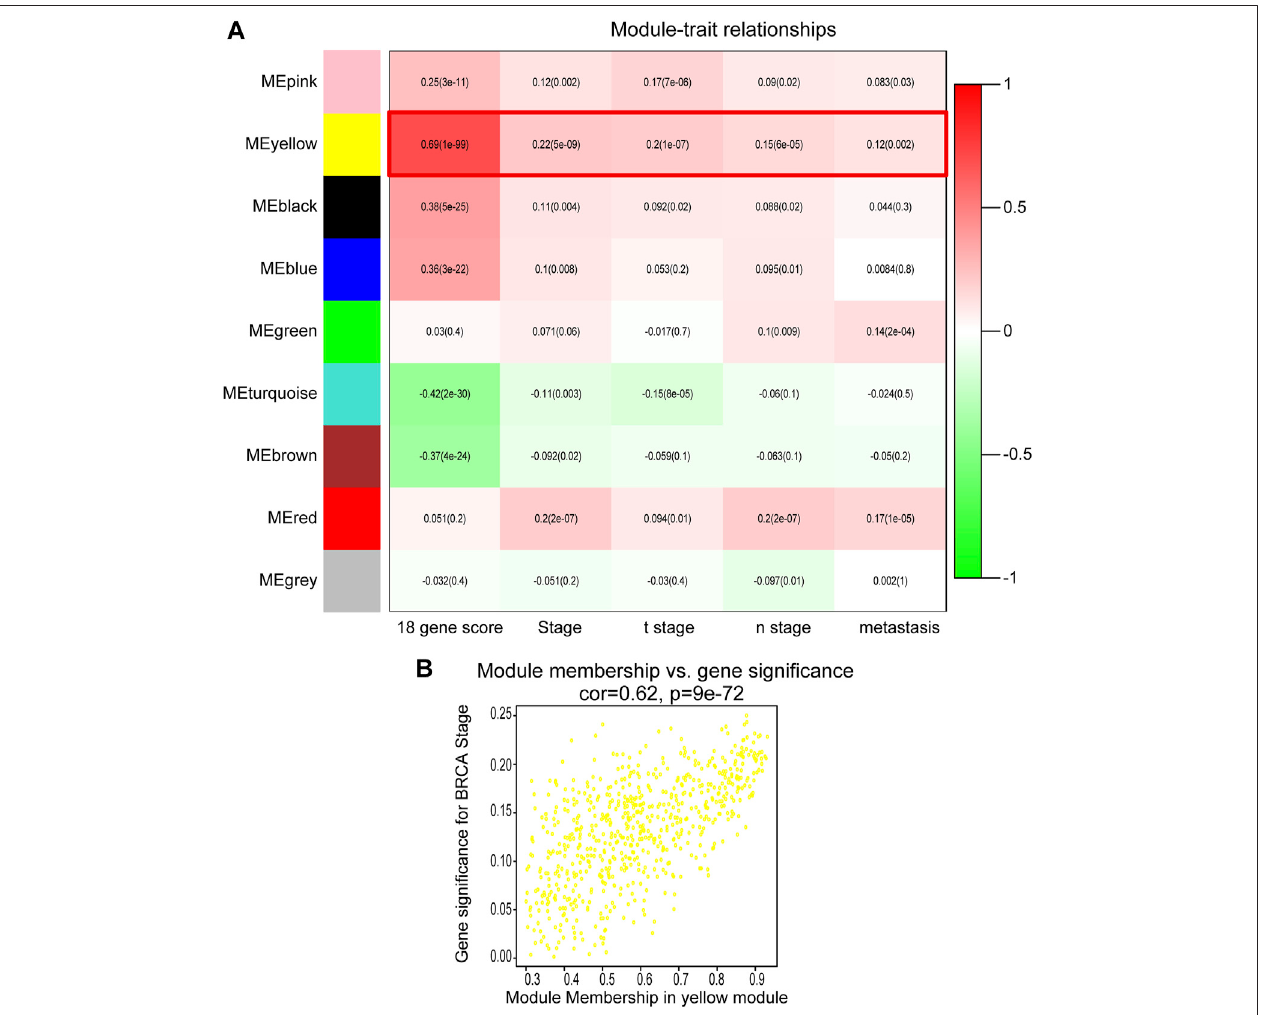
FIGURE 2 | Identi fi cation of modules correlated with the clinical traits of BRCA. (A) Heatmap to show the correlation between modules and clinical features of BRCA. p -values are shown in brackets. (B) Scatter plot analysis to show the association between Module membership in the yellow module and gene signi fi cance for BRCA